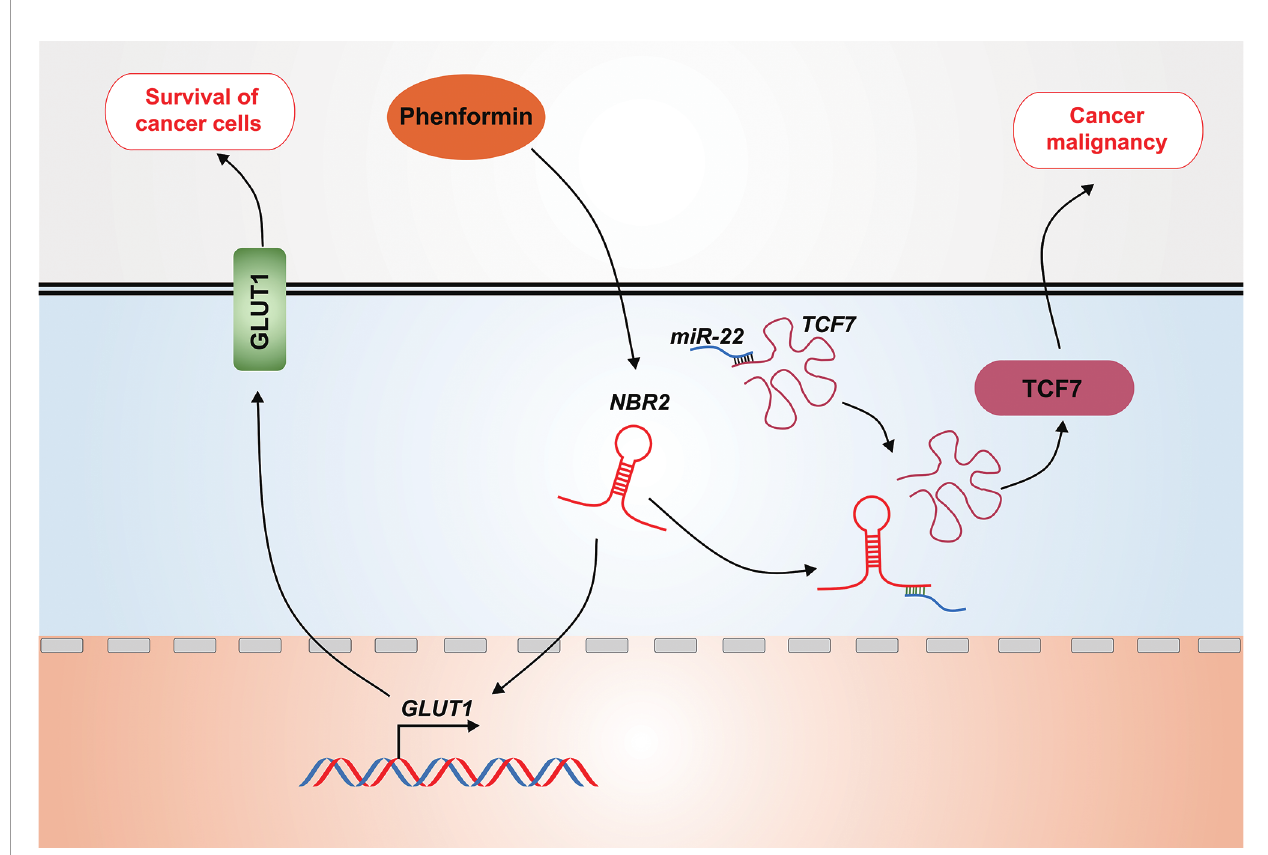
FIGURE 4 | Opposite roles of NBR2 in cancer. NBR2 functions as an adaptive responser that maintains cell survival in response to phenformin treatment by facilitating GLUT1 expression. In addition, NBR2 in the cytoplasm sponges miR-22 under conditions of glucose starvation, thereby counteracting miR-22 -induced TCF7 repression and aggravating the malignancy of hepatoblastoma